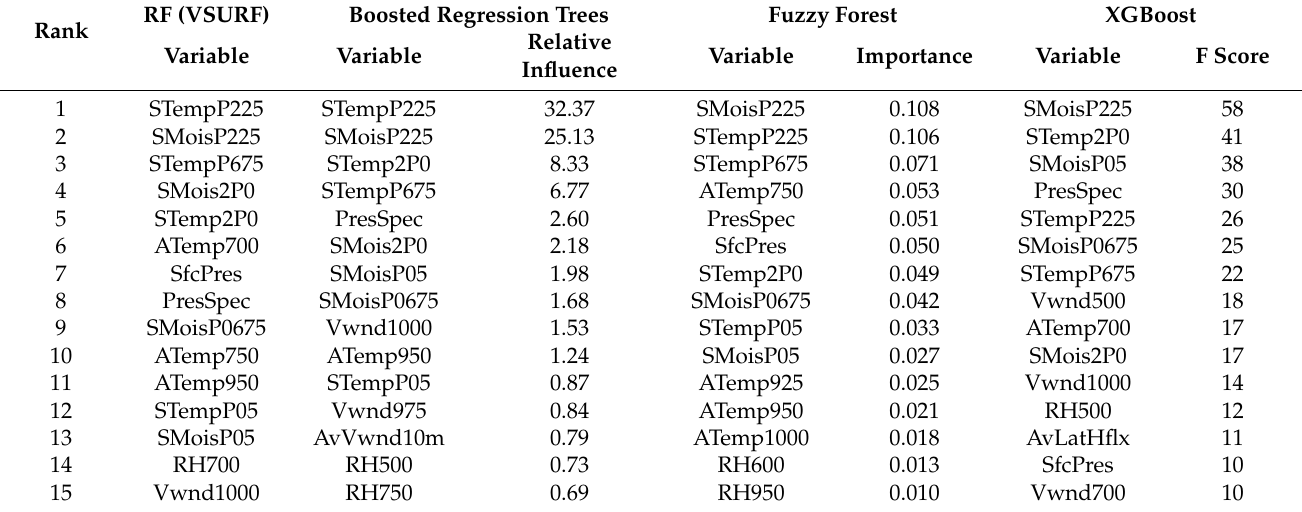
Table 5. Bushfire-influencing variables and their ranking obtained from different variable selection models. A brief explanation of the variables is presented in Table